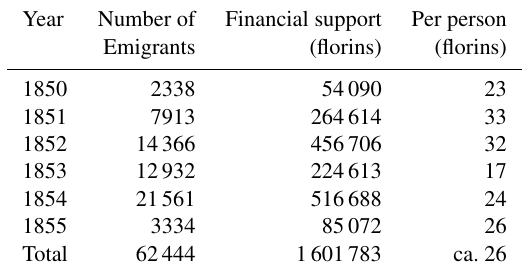
Table 1. Total financial support from the state, communities and private persons for the emigration from the Grand Duchy of Baden 1850–1855 (Fies,